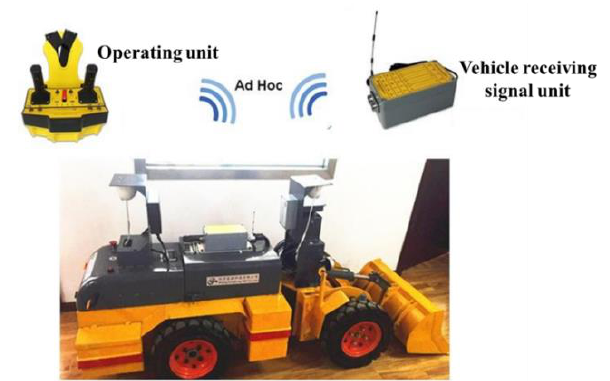
Figure 10. Mobile test platform for underground scenes.